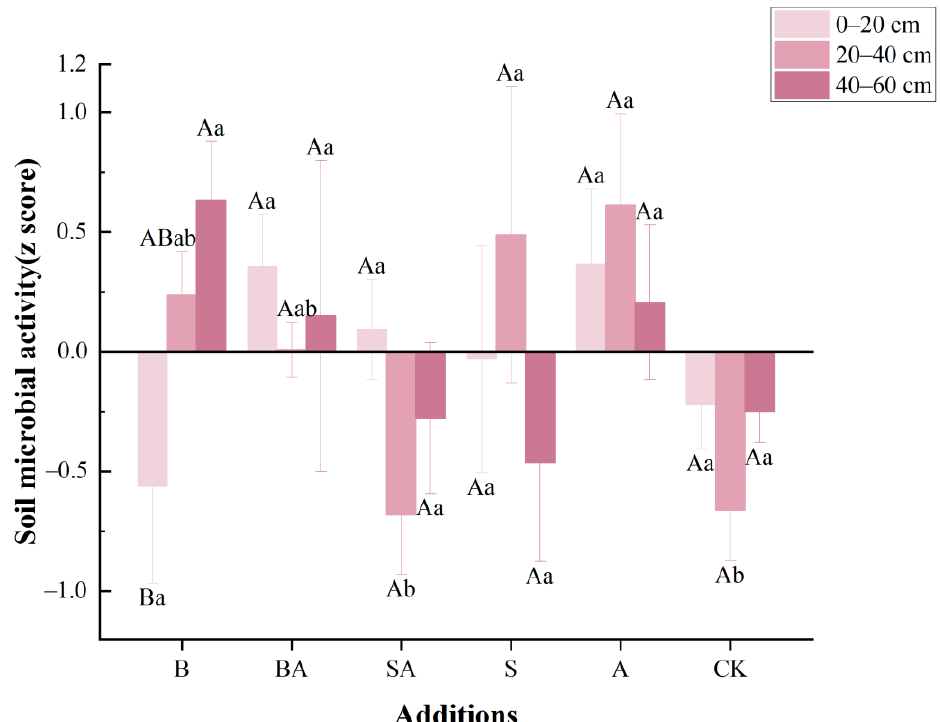
Figure 4. Variation in soil microbial activity indices between treatments. Different uppercase letters indicate significant differences between different soil layers under the same addition of treatment ( p < 0.05). Different lowercase letters indicate significant differences between additions in the same soil layer ( p < 0.05). Error bars refer to standard errors. The average of the z-score of each soil enzyme activity was calculated to indicate soil microbial activities.